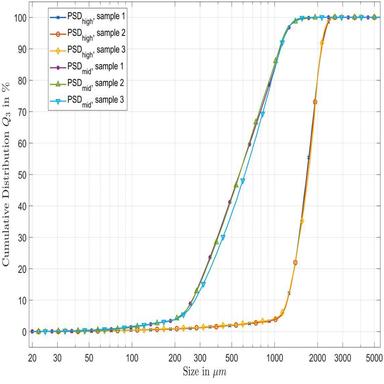
Particle size distribution in run A.